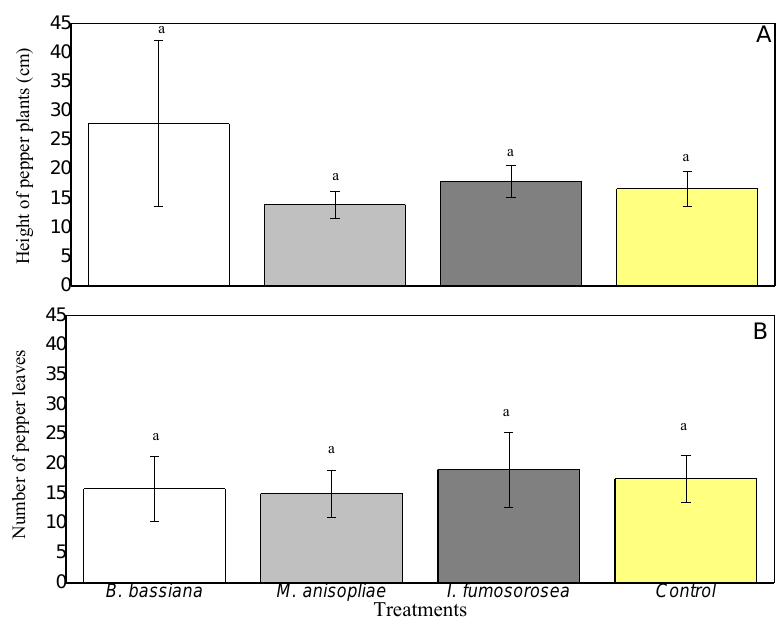
Figure 5. C. annum growth in terms of ( a ) height of pepper plants and ( b ) number of pepper leaves. Mean ± sd values with the same superscript letter are not different in a significant way (Bonferroni’s test: p < 0.05).